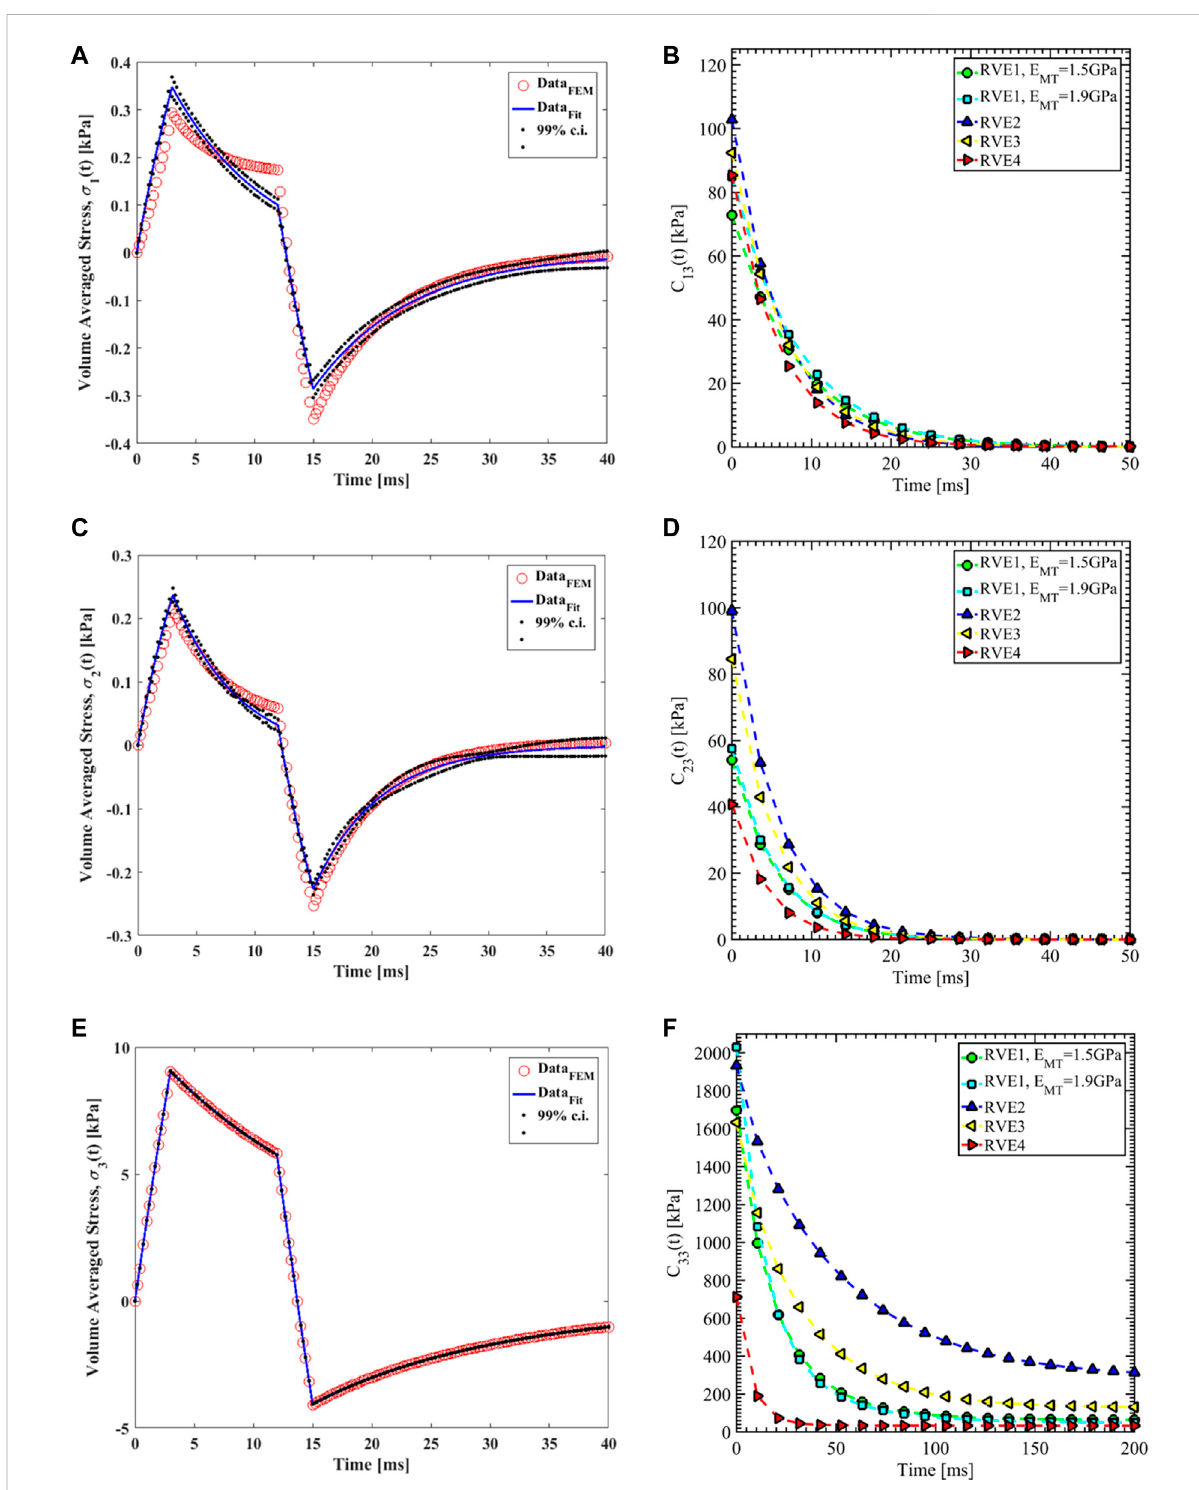
FIGURE 11 (A) Nonlinear regression data fi t with 99% con fi dence interval (c.i.) is shown for volume averaged normal stress in direction 1 for RVE-1, E MT (cid:2) 1 . 5 GPa forloadcase3. (B) Comparisonof C 13 ( t ) fordifferentRVEs. (C) Nonlinearregressiondata fi twith99%con fi denceinterval(c.i.)isshown for volume averaged normal stress in direction 2 for RVE-1, E MT (cid:2) 1 . 5 GPa for load case 3. (D) Comparison of C 23 ( t ) for different RVEs. (E)